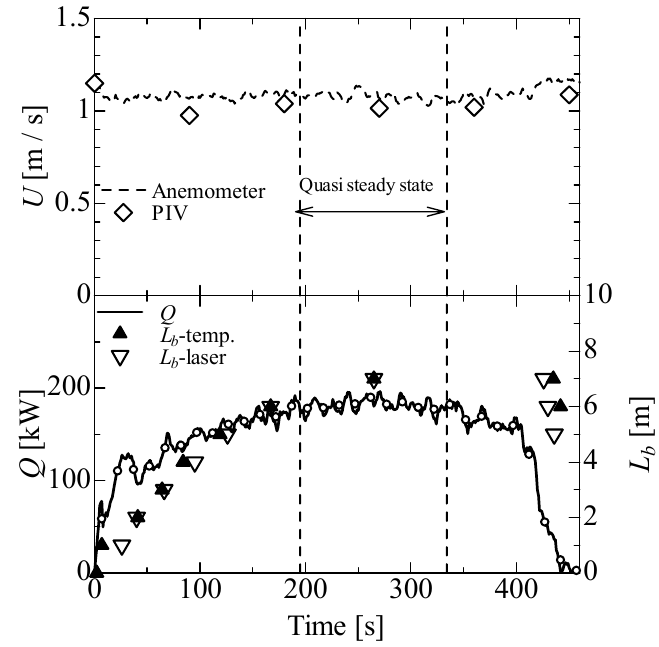
Fig. 3 Time curves of the heat release rate Q , ventilation velocity U , and backlayering distance L b , in the case of a burning area of A f = 0.15 m